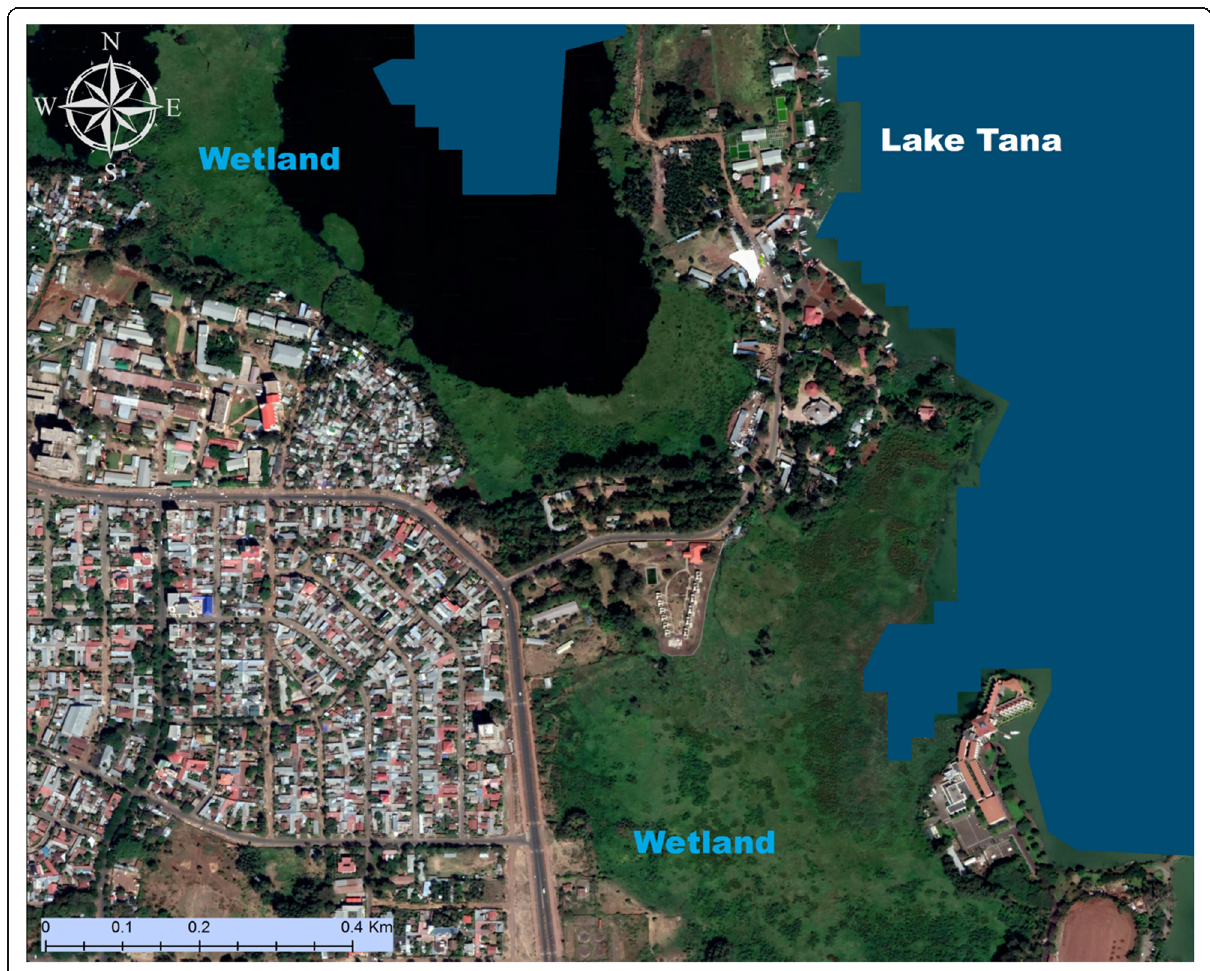
Fig. 3 A high-resolution Google-Satellite image showing part of the Bahir Dar City, where infrastructure development, residential and hotel construction are devastating lacustrine wetlands (Source: SASPlanet in